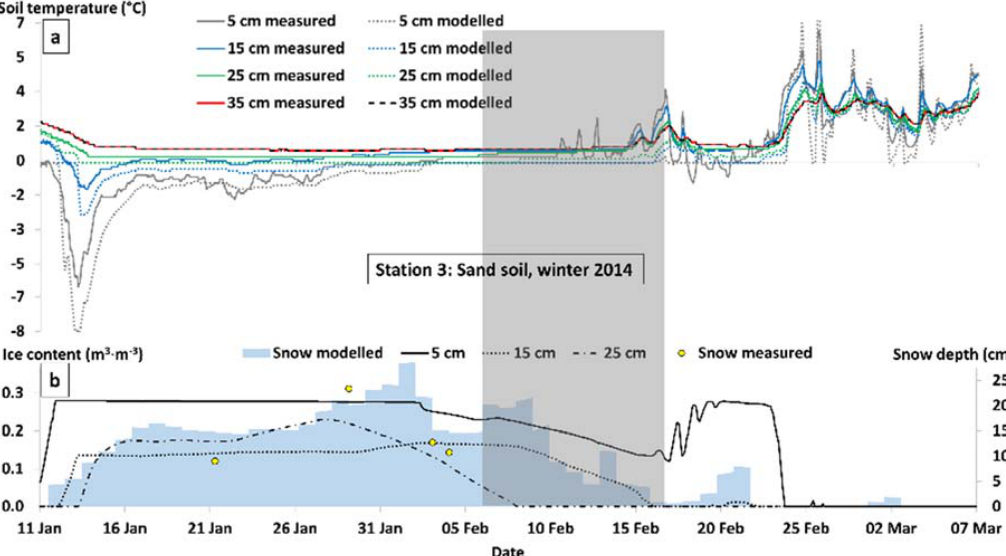
Figure 8. Diagram of ( a ) modelled and measured soil temperature at four depths (5, 15, 25 and 35 cm) in the sand soil (at Station 3) during winter 2014; diagram of ( b ) measured and modelled snow depths at Station 3 and modelled ice content at four depths in the sand soil (was zero at 35 cm). The duration of the rain event of interest is marked with a grey band.